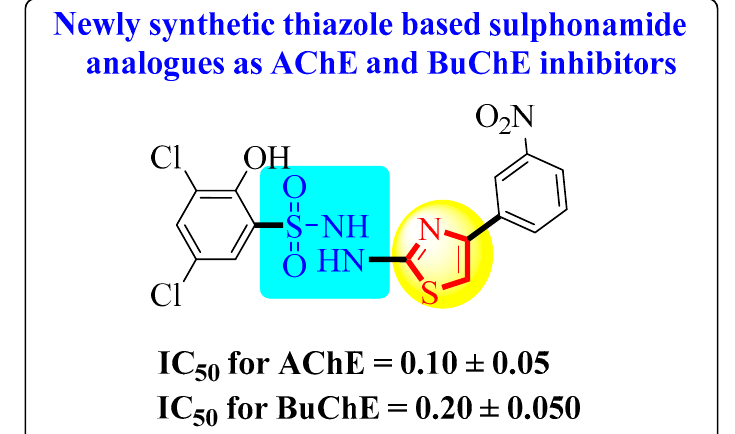
Figure 2. The rationale of the current study.